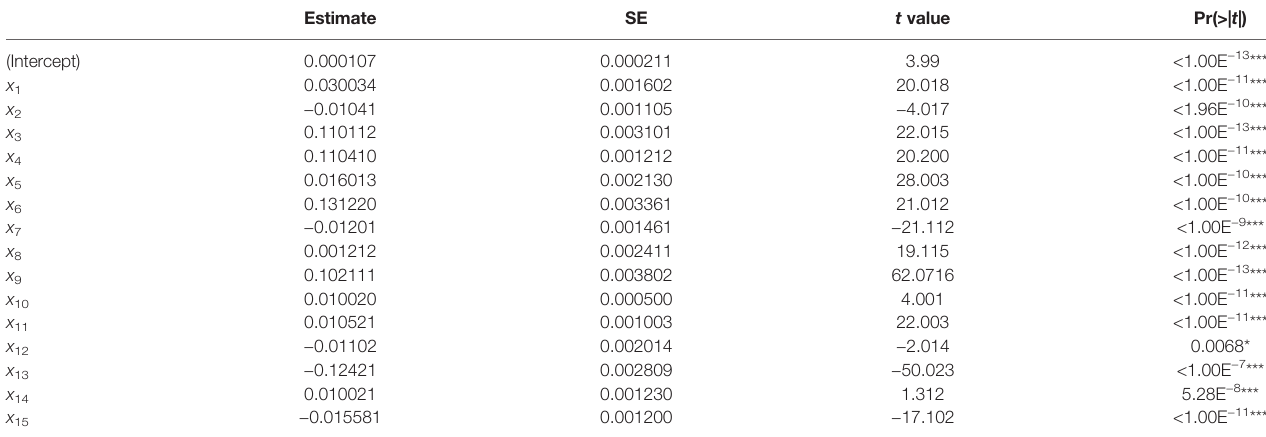
TABLE 2 | K -fold cross-validation using the Bioconductor “ boot ” package based on Gaussian dispersion parameters.